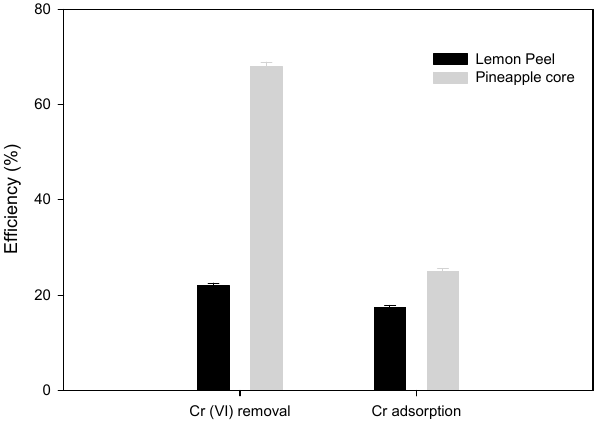
Figure 1. Screening of wastes pineapple core (PP) and lime peel (LM) for the removal of Cr(VI) and total Cr. Operational conditions: 0.5 g of biosorbent, 50 mL of a solution 50 mg/L Cr(VI) at 25 °C and 150 rpm during 24 h.